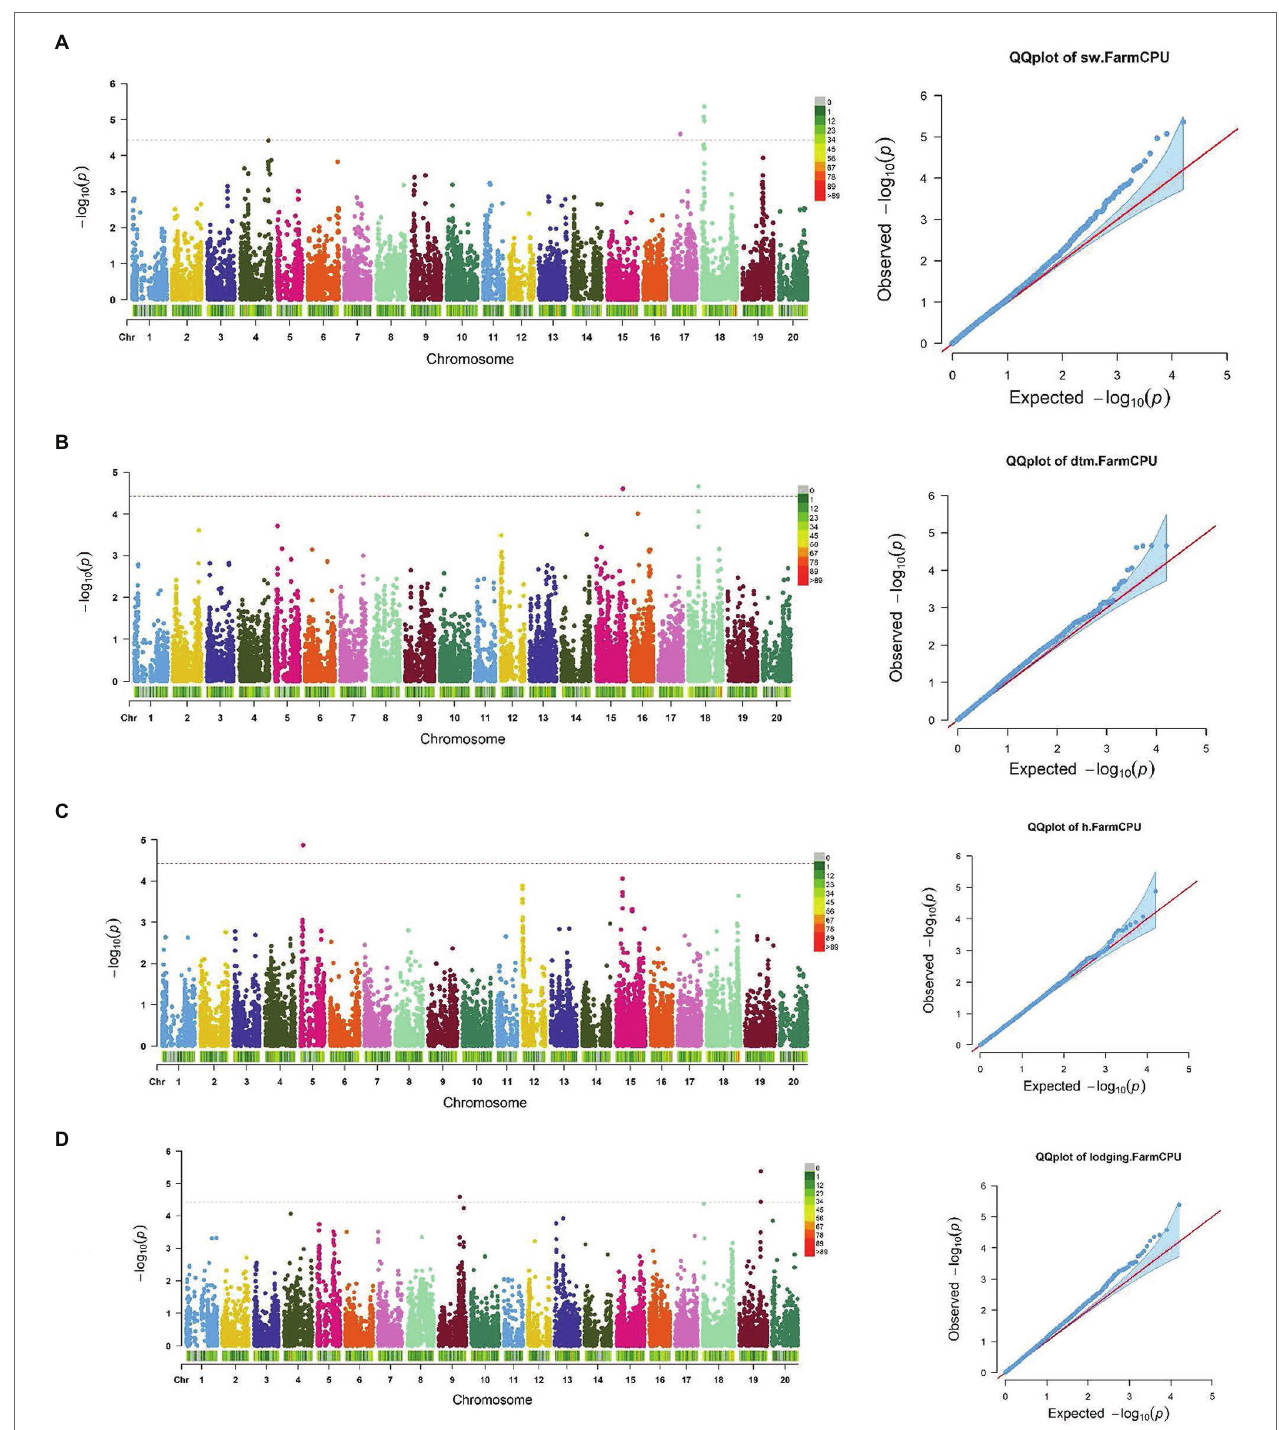
FIGURE 3 | Manhattan plots and corresponding Q-Q plots showing significantly associated SNPs detected in combined environment GWAS analysis for the agronomic traits: (A) 100 seed weight; (B) days to maturity; (C) plant height; and (D) lodging